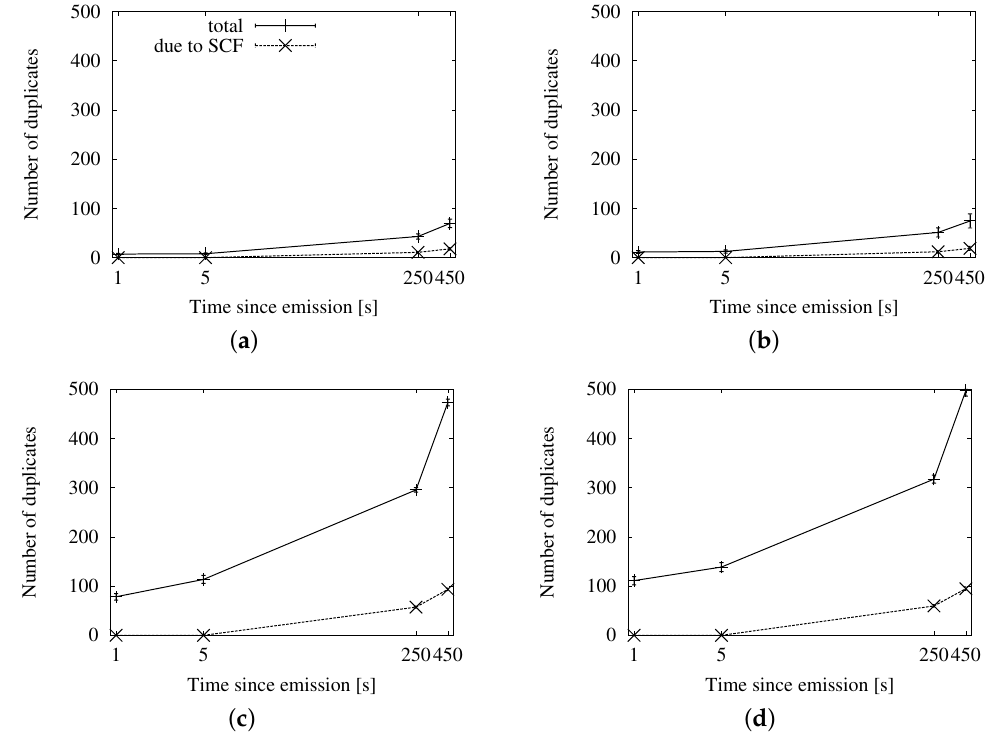
Figure 8. Sent duplicates with the speed-adaptive approach for store-carry-forward in the New York scenario: ( a ) roadway scheme, 25 vehicles/km 2 ; ( b ) map-based scheme, 25 vehicles/km 2 ; ( c ) roadway scheme, 100 vehicles/km 2 ; ( d ) map-based scheme, 100 vehicles/km 2